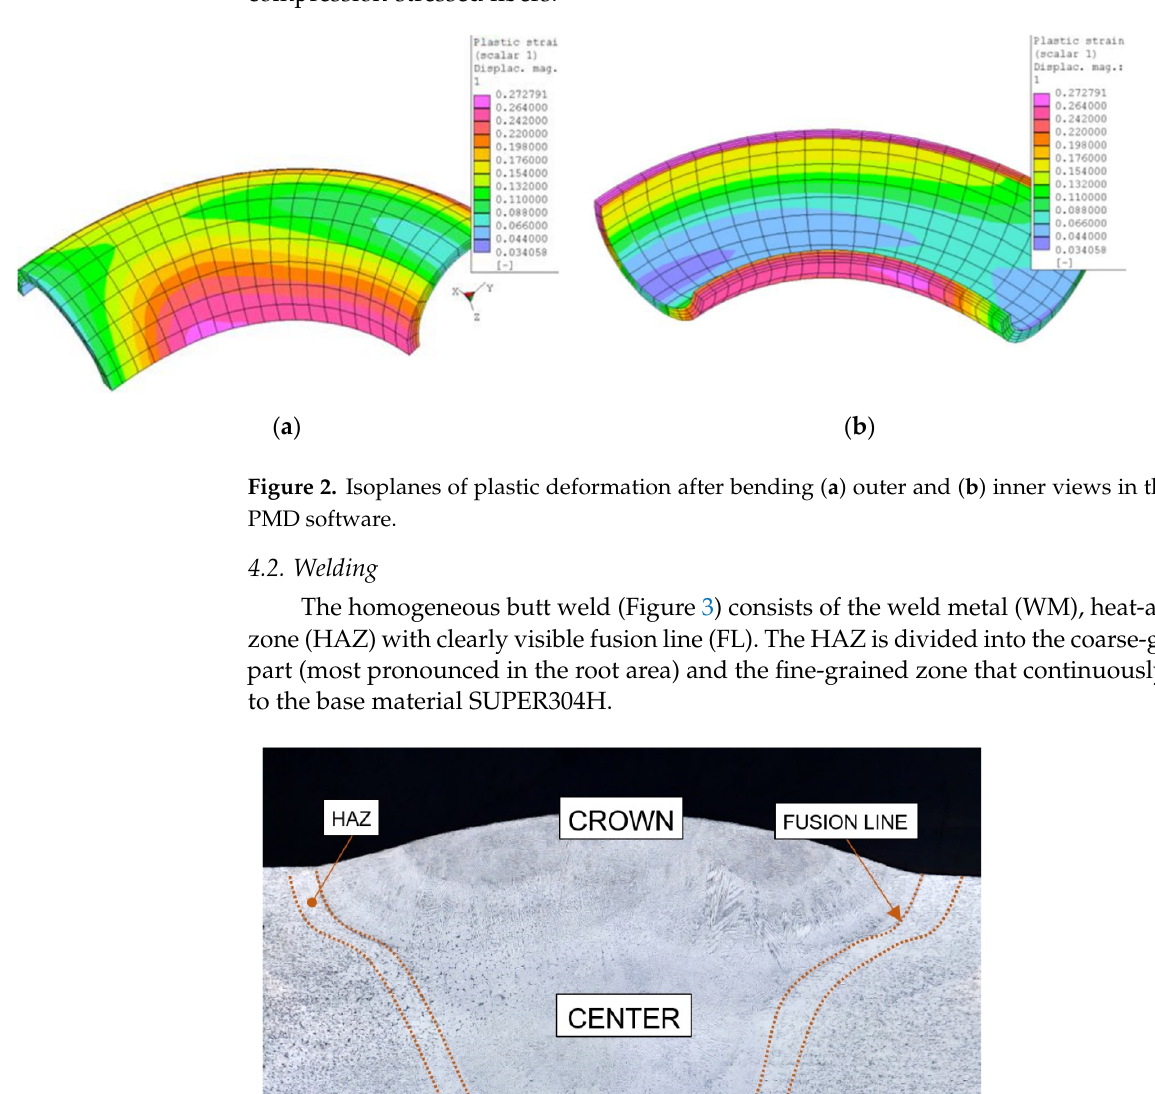
Figure 1. Power plant boiler operation temperature histogram.